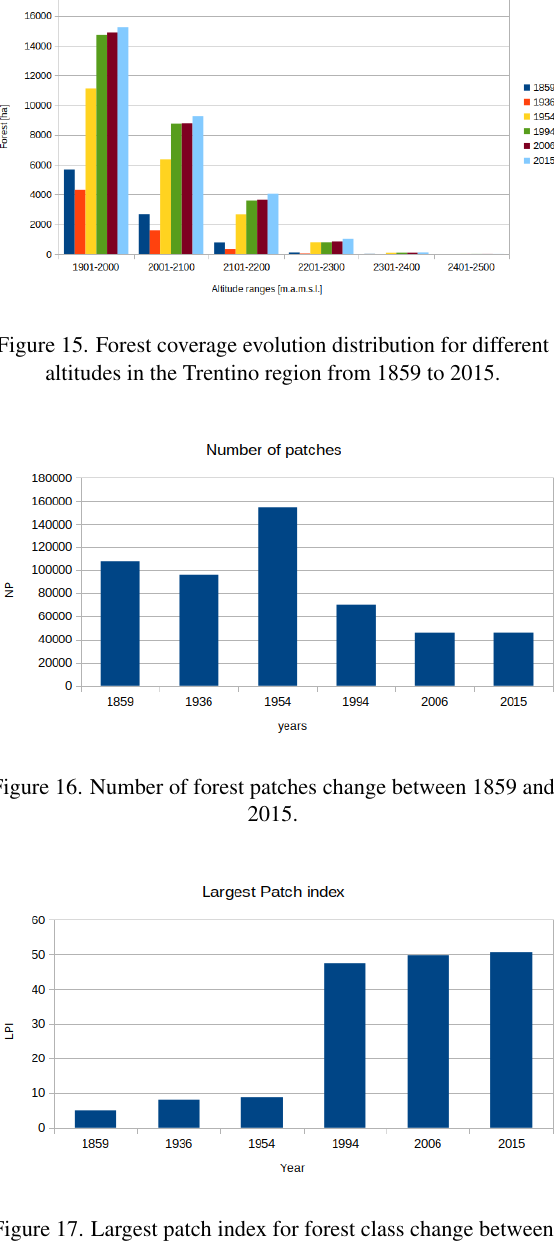
Figure 17. Largest patch index for forest class change between 1859 and